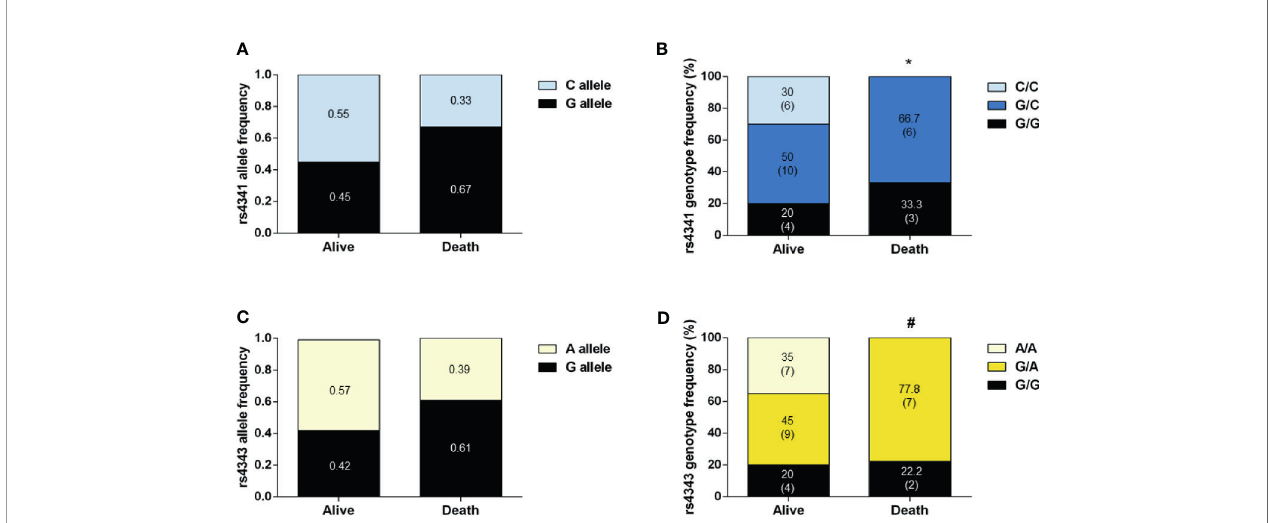
FIGURE 4 | Genotype and allele frequencies of COVID-19 patients in ICU who survived or who died. Allele frequencies of rs4341 (A) and rs4343 (C) polymorphisms. Data are presented as proportions. Genotype frequencies of rs4341 (B) and rs4343 (D) polymorphisms. Data are presented as percentages. The number of patients is indicated in brackets. * p < 0.05 vs survivors for G carriers (GG+GC vs CC). # p < 0.05 vs survivors between GG and GA and AA, GG+GA vs AA). All data were adjusted for age and sex.